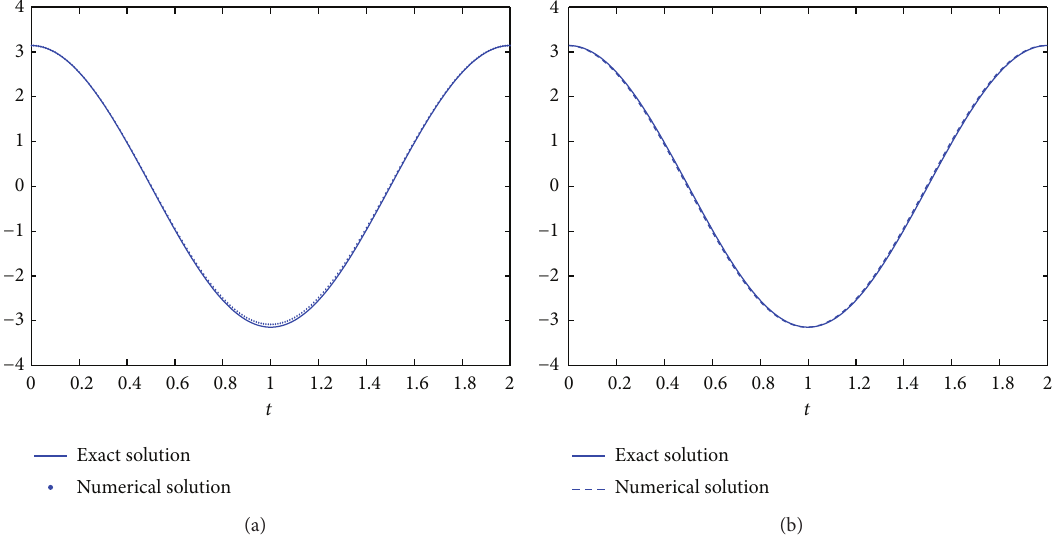
̂𝑓(𝑡) with no noisy data, (a) MLS and (b)